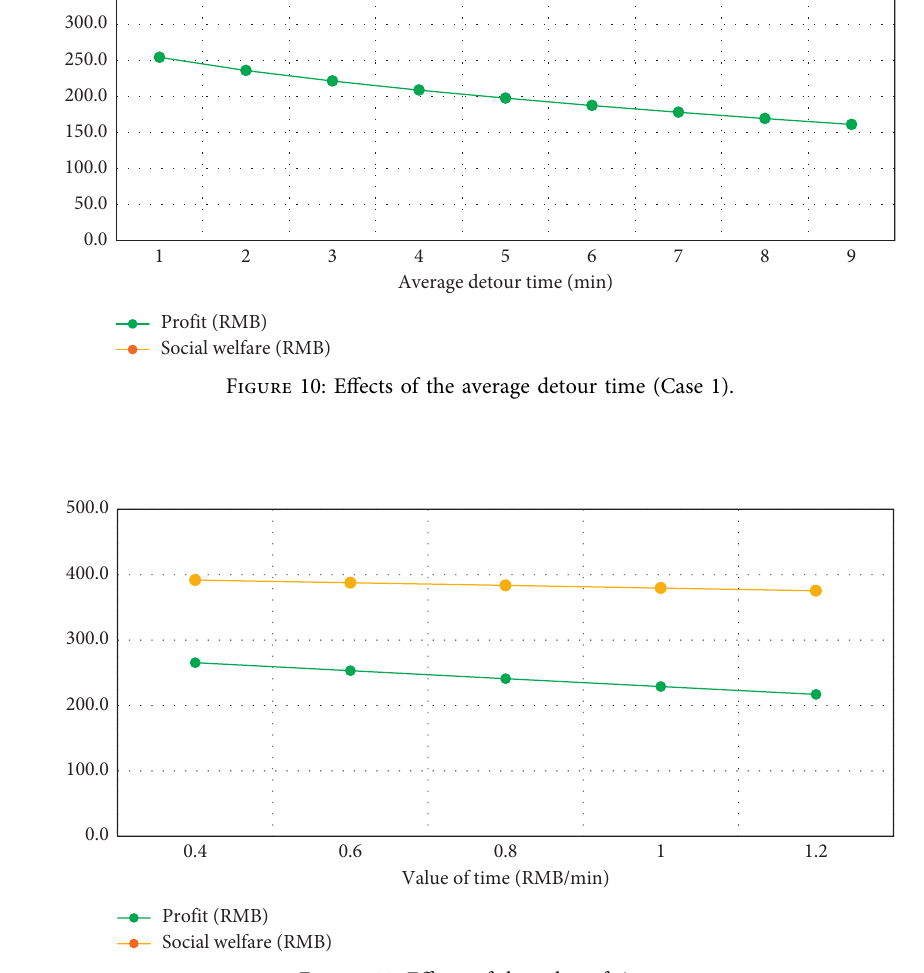
Figure 11: Effects of the value of